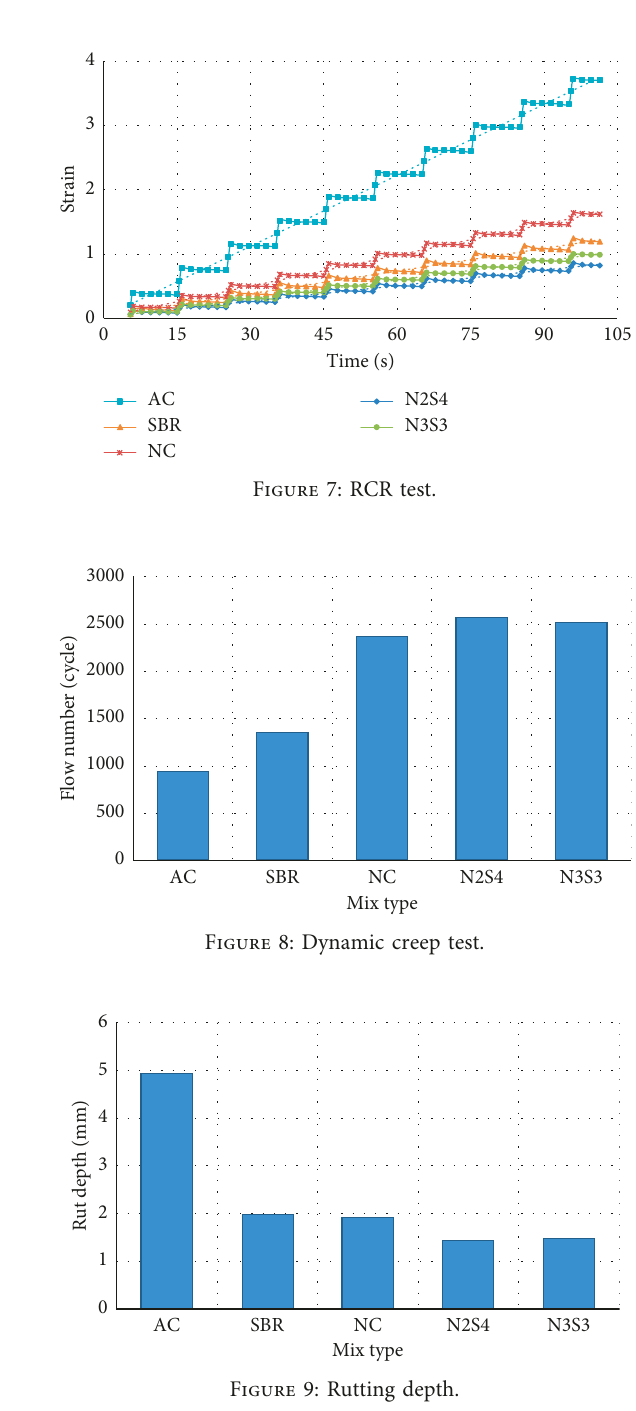
Figure 9: Rutting